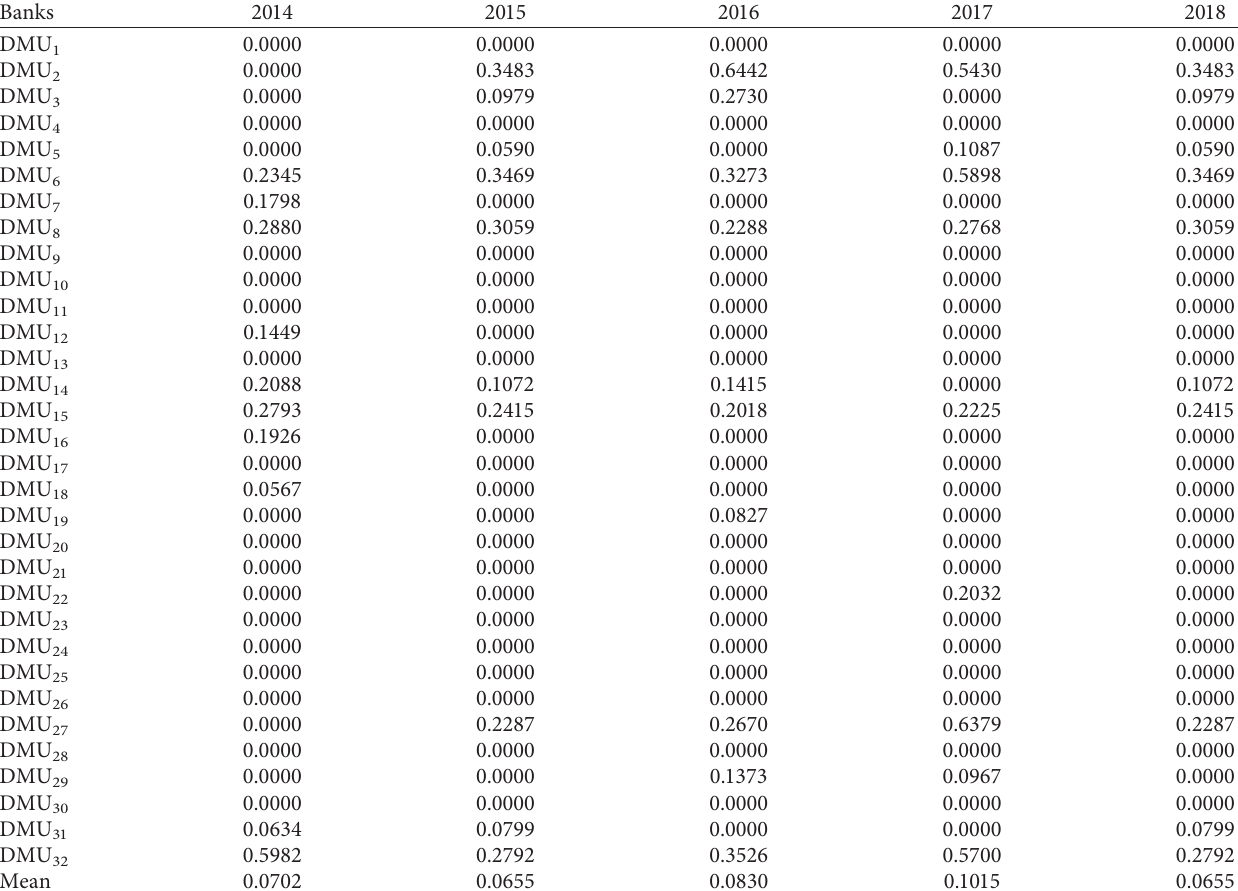
Table 4: Inefficiency scores of 32 listed banks from 2014 to